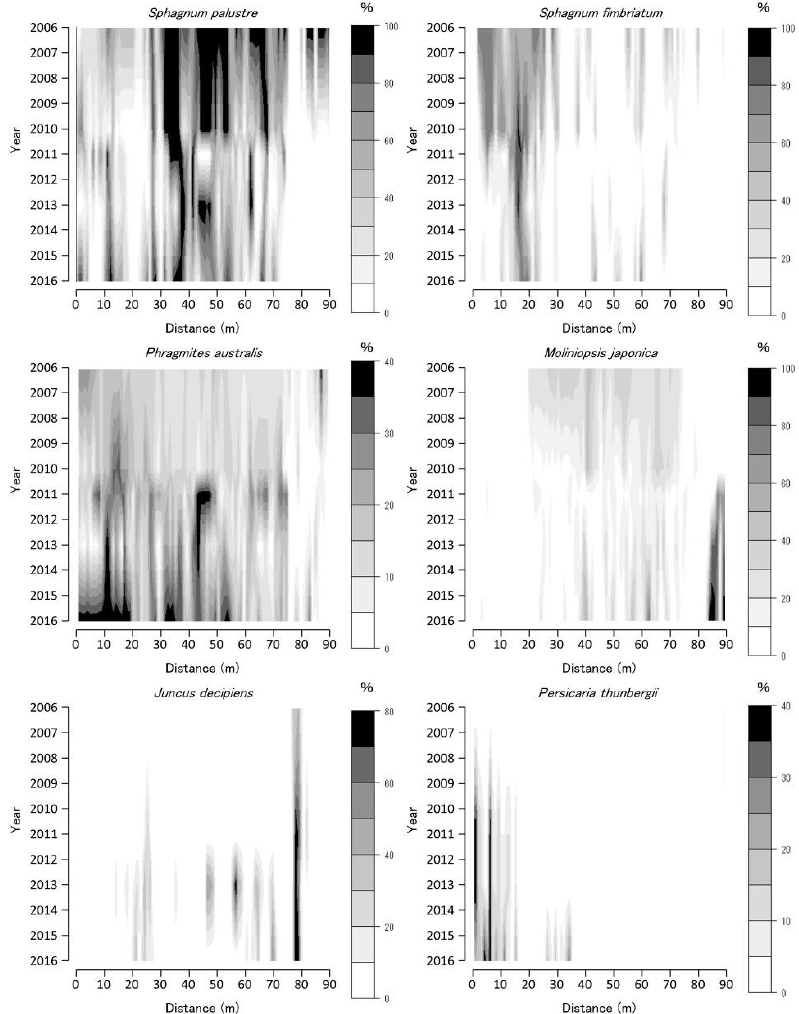
Figure 5. Coverage of Sphagnum palustre , Sphagnum fimbriatum , Phragmites australis , Moliniopsis japonica , Juncus decipiens , and Persicalia thunbergii along Bougatsuru transect 2 (BGT transect 2). Data were collected at every 1 × 1 m 2 quadrat placed sequentially on the transect. Countered figures of coverage on the axes of year and position were drawn by interpolating data collected in 2006, 2010, 2011, 2013, and 2016.